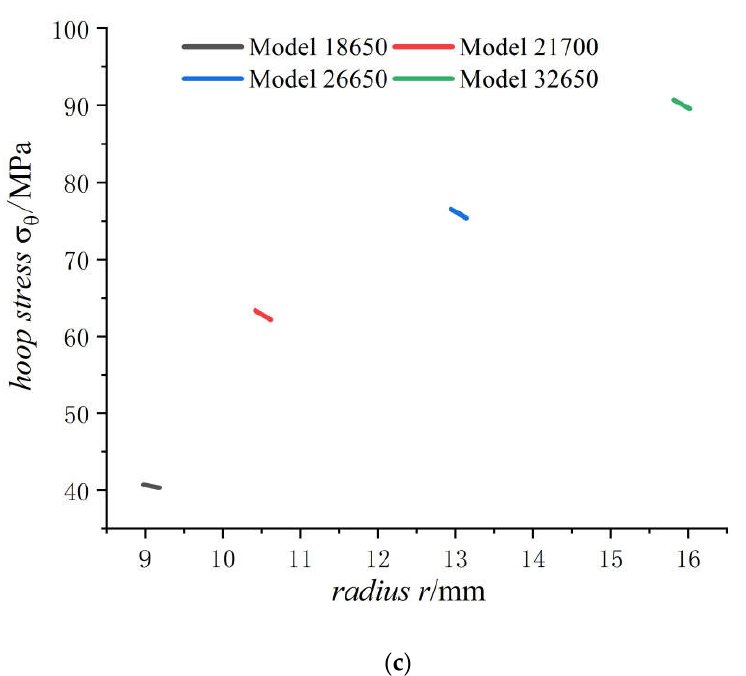
Figure 9. Displacements and stresses of case of four types of lithium-ion power batteries on a fully charged state: ( a ) displacements; ( b ) radial stresses; ( c ) hoop stresses.